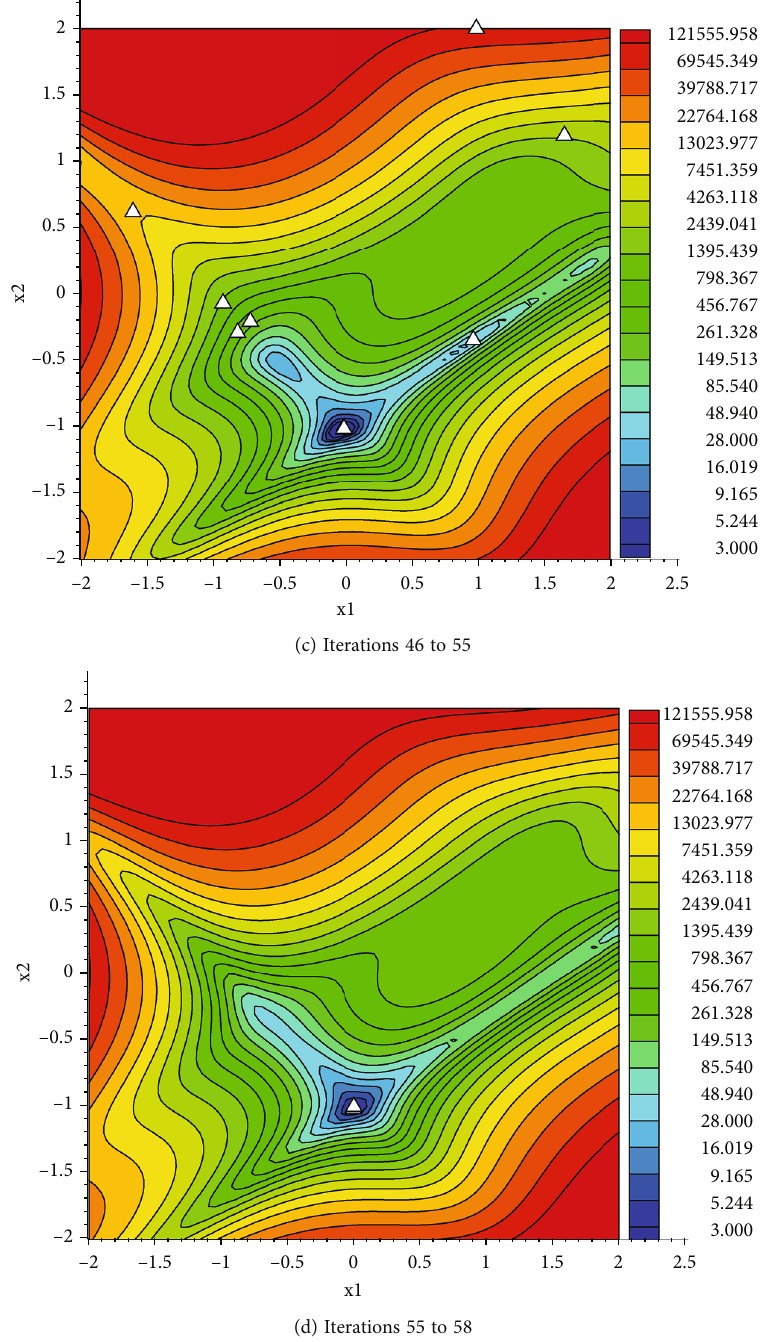
Figure 10: The in fi ll process of the KSE